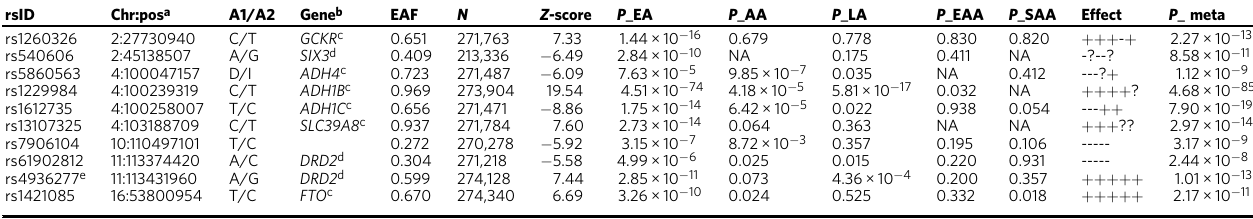
The loci shown represent completely independent signals after conditioning analyses. A1 effect allele, A2 other allele, EAF effective allele frequency, EA European American, AA African American, LA Latino American, EAA East Asian American, SAA South Asian